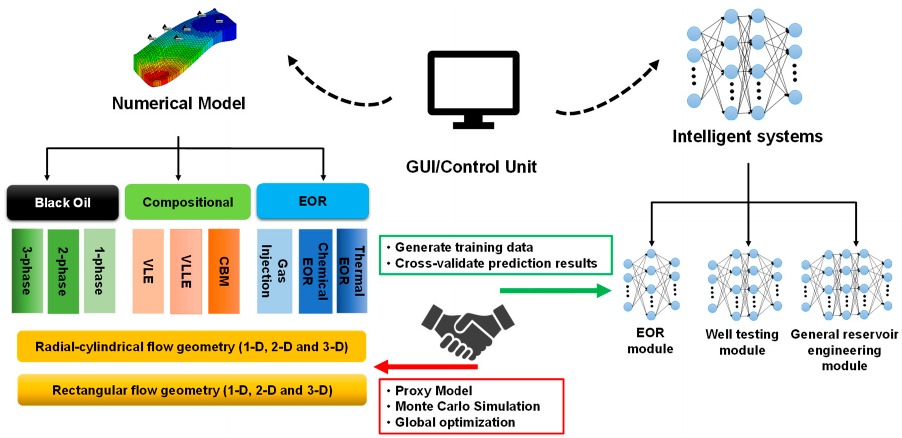
Figure 10. Hand-shaking architecture between AI models and numerical models. Note: VLE indicates vapor-liquid-equilibrium, VLLE is vapor-liquid-liquid equilibrium and CBM refers to coalbed methane.